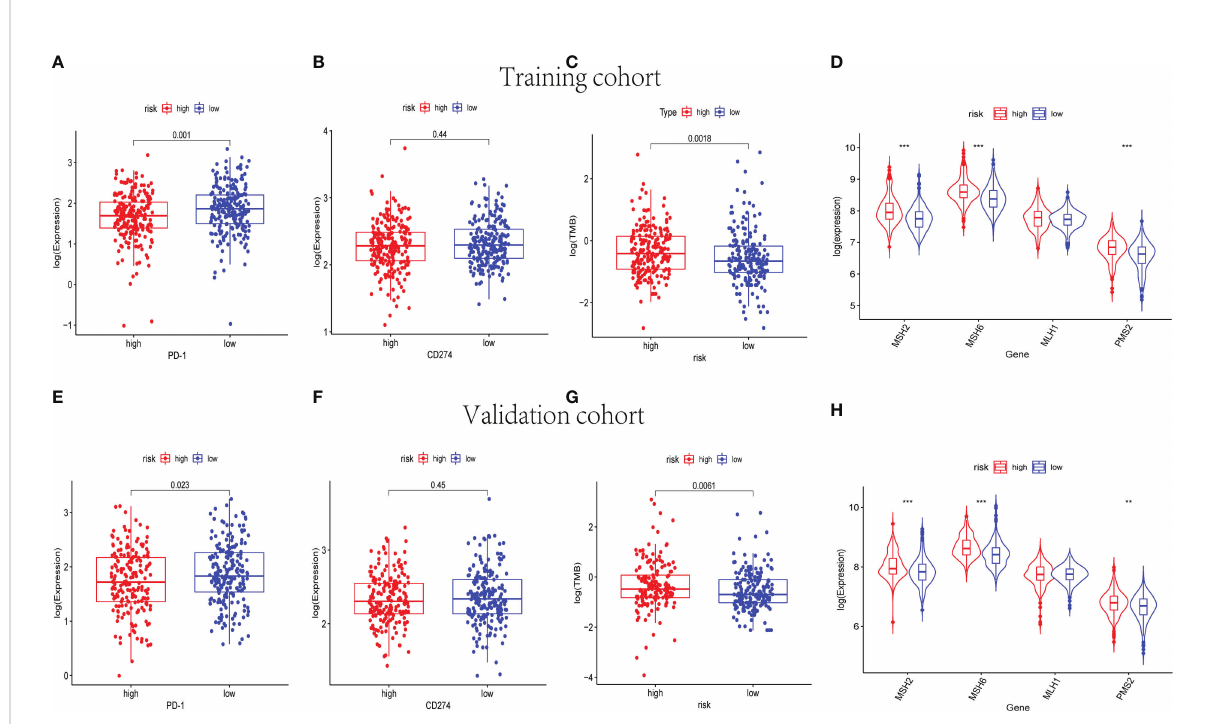
FIGURE 10 The immunotherapy response prediction analysis for the nine-cuproptosis-related lncRNA risk model. The expression levels of immune checkpoint- related genes PD-1 and PDL-1 in training (A, B) and validation (E, F) groups (p< 0.05). The differences in TMB between the high- and low- risk sets in training (C) and validation (G) groups (p< 0.05). The expression of MMR genes of BC samples in training (D) and validation (H) sets, including MSH2, MSH6, MLH1, and PMS2. TMB, tumor mutational burden; MMR, mismatch repair; BC, breast cancer. ** indicated P < 0.01 and *** indicated P <